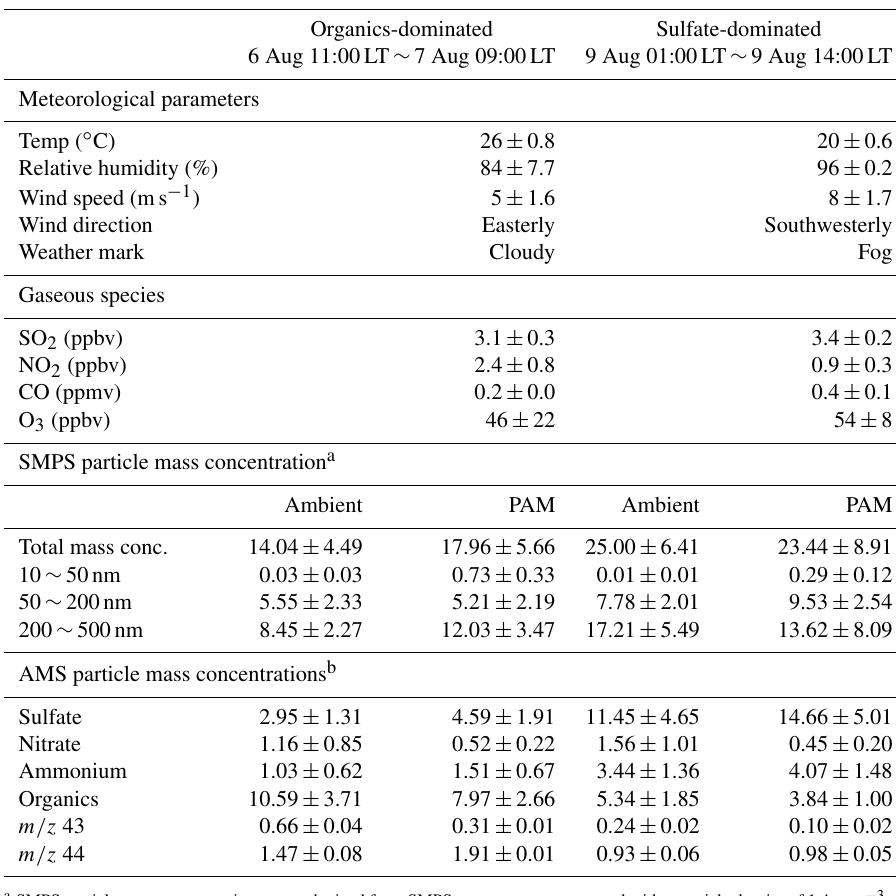
Table 1. Meteorological parameters and measurement summary for organics-dominated and sulfate-dominated episodes.